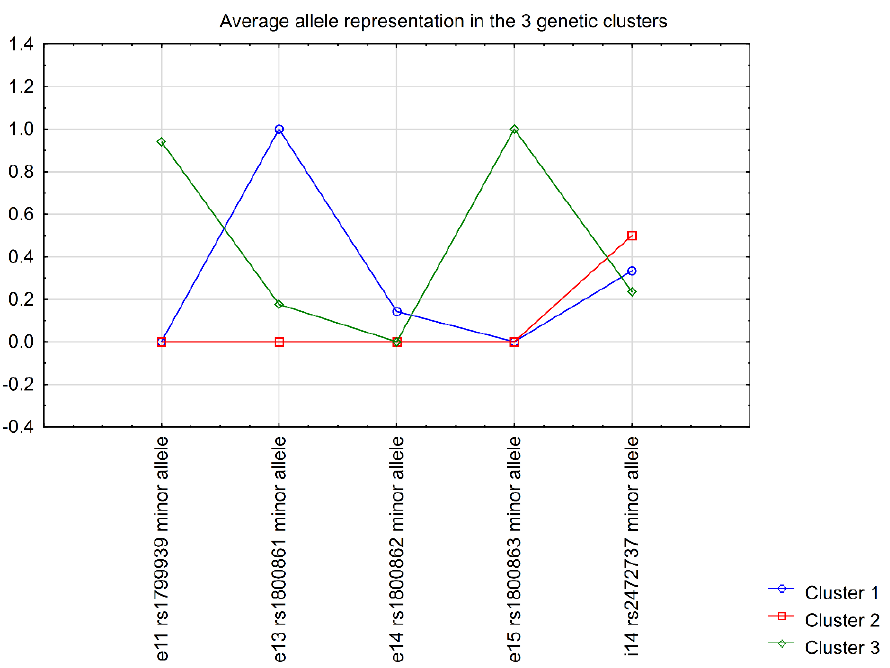
Figure 1. Graphic representation of clusters discriminated by unsupervised k−means clusterisation. The clusterisation divided the MTC group into three clusters that maximally differed genetically between each other on the basis of the five investigated RET